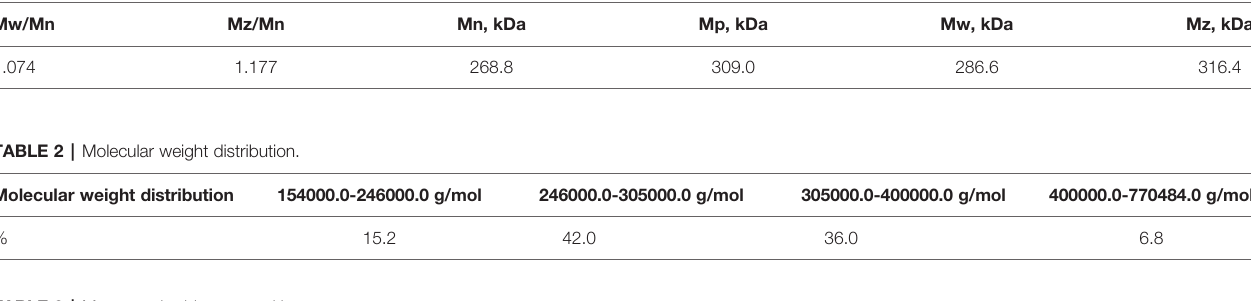
TABLE 3 | Monosaccharide